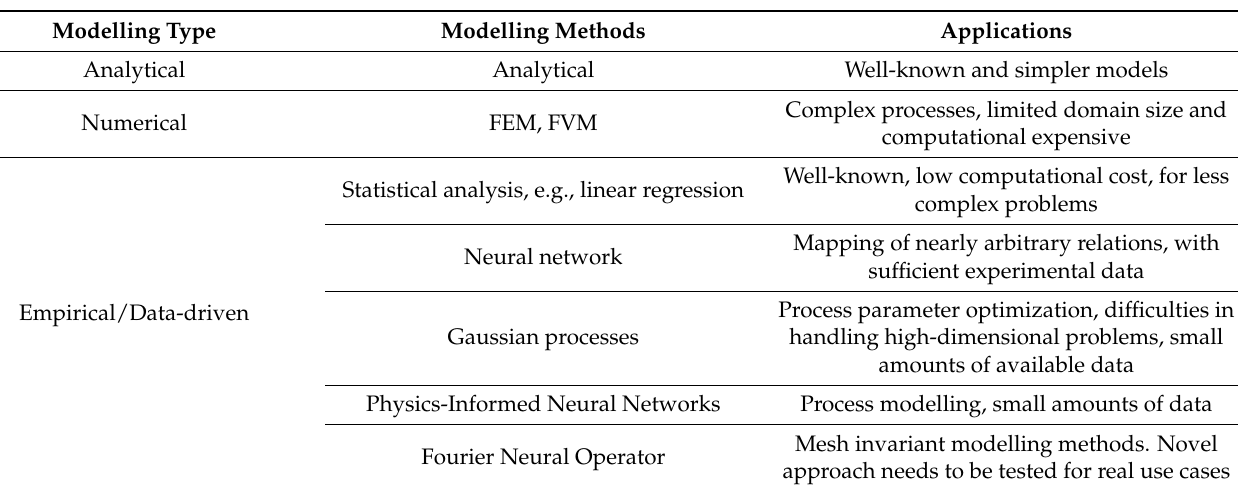
Table 2. Overview of sensor fusion